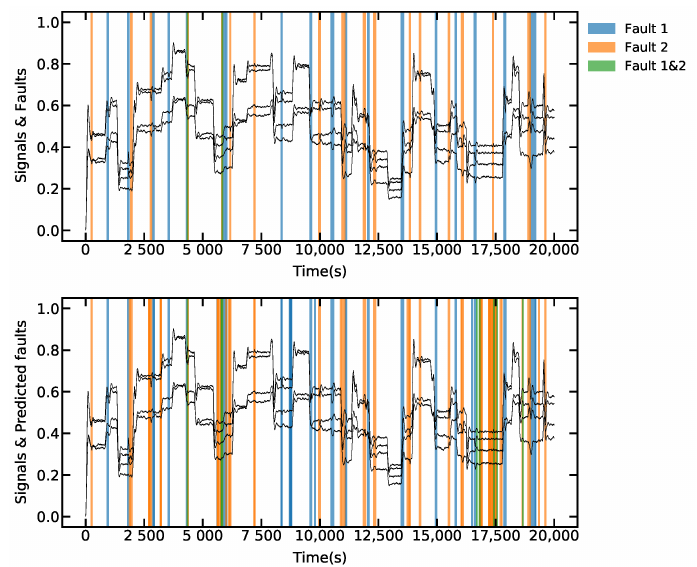
Figure 8. Actuator faults detection, the faults are represented in the shaded areas, states are given in black for reference. Above: faults labeled in the data-set. Below: faults detected by the system.